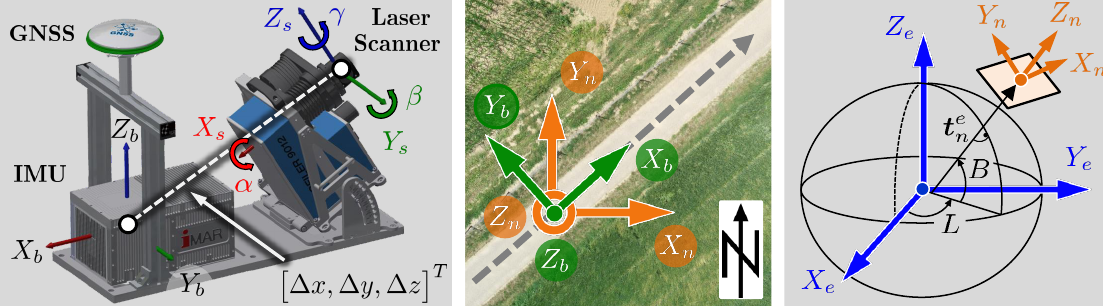
Figure 2. Different coordinate frames (i.e., s(canner)-frame, b(ody)-frame, n(avigation)-frame, and e(arth)-frame) and transformations for generating a georeferenced 3D point